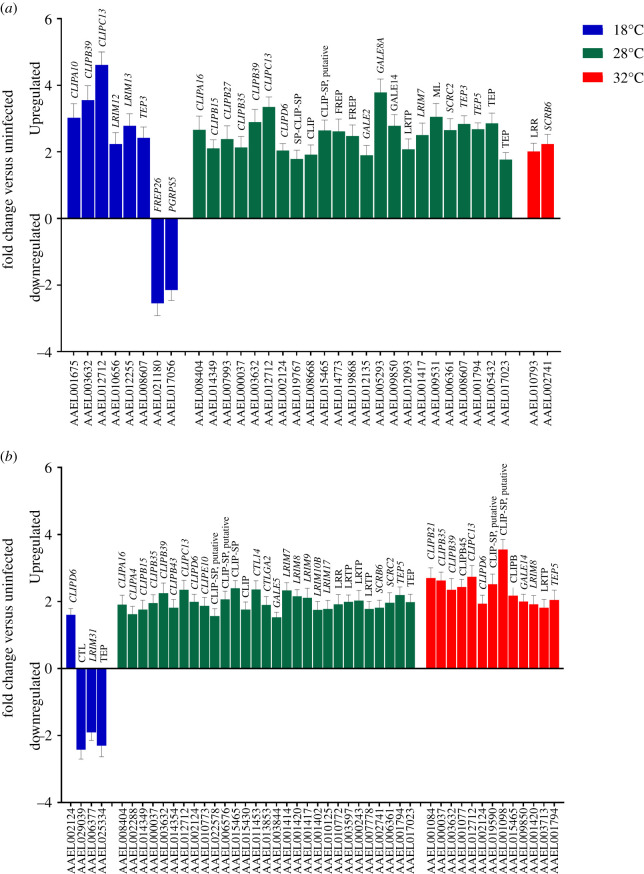
Differentially expressed genes (DEGs) related to pathogen recognition at (a) 3 dpi and (b) 7 dpi, in CHIKV-infected Ae. aegypti versus uninfected controls. CTL: C-type lectin; LRIM: leucine-rich immune receptors; LRR: leucine-rich repeat-containing proteins; LRTP: leucine-rich transmembrane protein; FREP: fibrinogen-related proteins; ML: Niemann-Pick receptors; GALE: galectin; PGRP: peptidoglycan recognition proteins; SCR: scavenger receptors; TEP: thioester proteins. Error bars represent standard error of the mean.